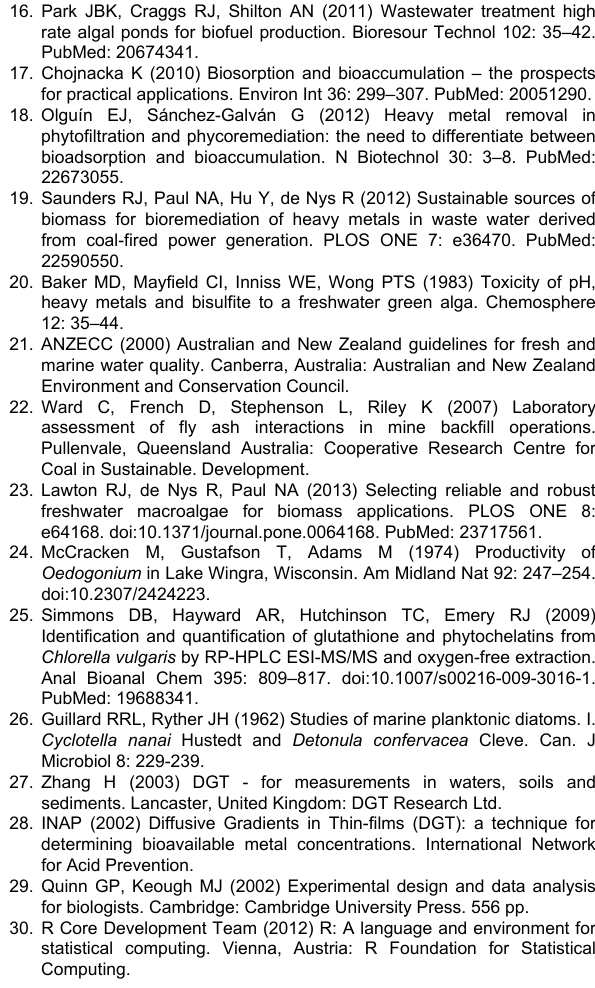
Table S1. Analyses of Variance of element flux to the Diffusive Gradient in Thin Film units under different CO addition regimes. Significant main effects or interactions (P < 0.05) are highlighted in bold.